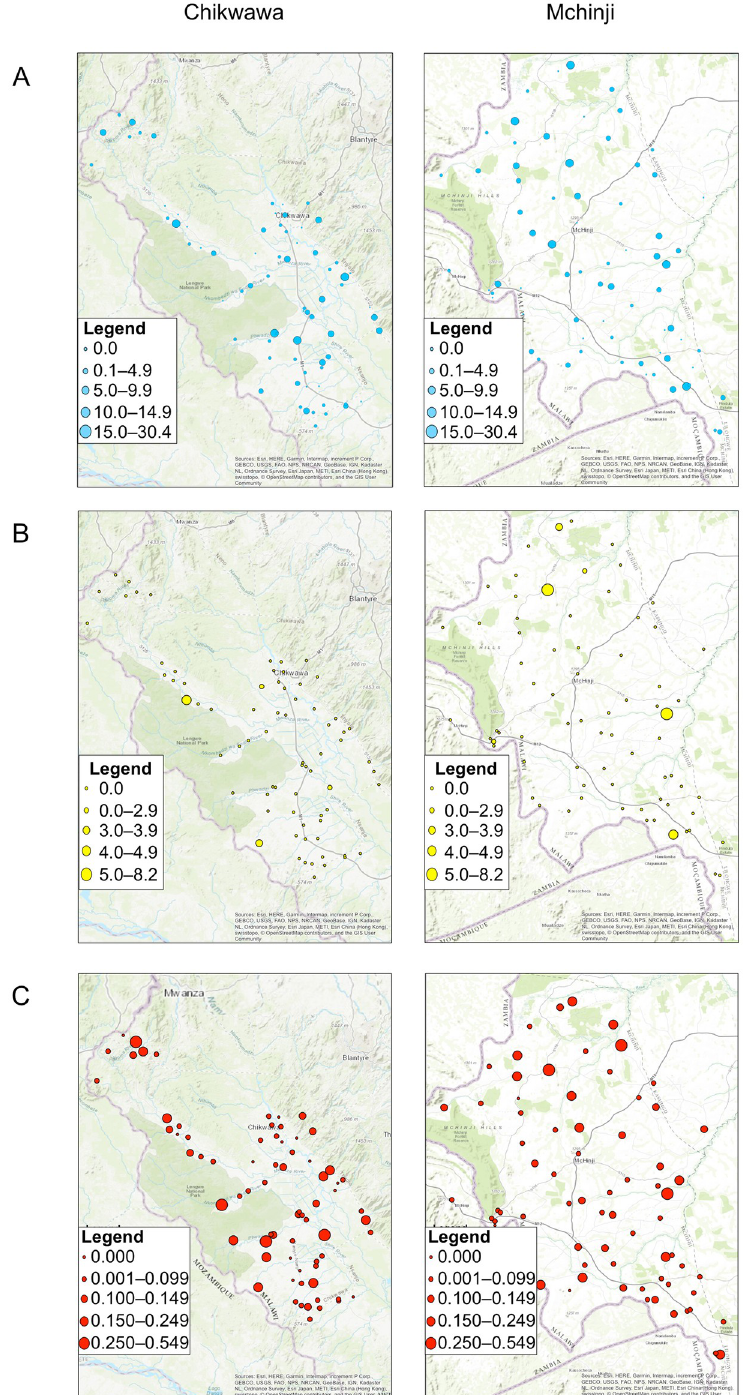
Fig 1. Mapping of indicators of trachoma in Chikwawa and Mchinji. Cluster level prevalence of (A) TF, (B) C . trachomatis infection and (C) anti-Pgp3